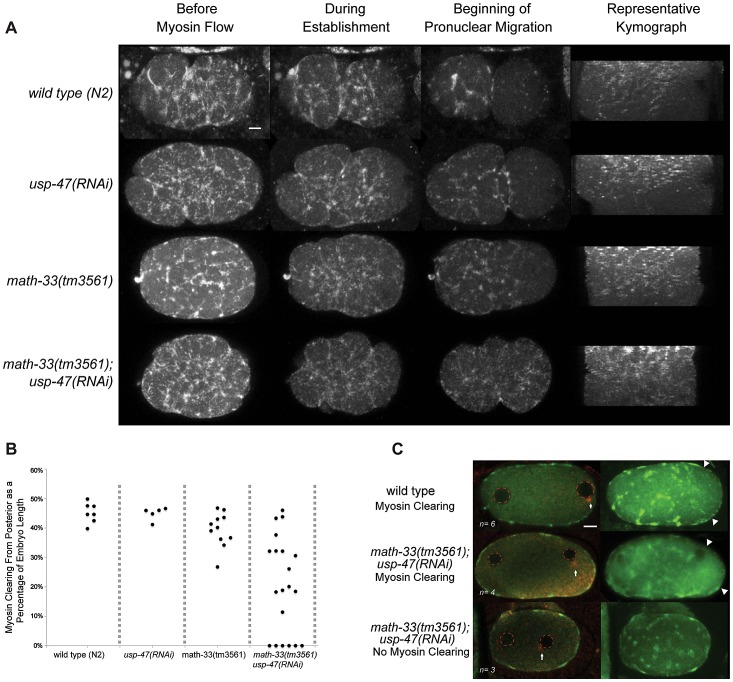
The posterior to anterior myosin clearing is defective in math-33(tm3561); usp-47(RNAi).(A) Time-lapse confocal images of embryos expressing NMY-2::GFP. The maximum projections of sections through the cortex of the embryo show the localization of NMY-2::GFP foci at three stages. Kymographs illustrate the pattern of myosin clearing and flow over time. About halfway through the kymographs (from top to bottom), large myosin foci transition into smaller myosin puncta. (B) The extent of myosin absence from the posterior (clearing) was measured as a proportion of the embryo length and the maximum level of clearing was recorded; each data point represents one embryo. (C) Confocal stacks of embryos immunostained for NMY-2 (green) and tubulin (red). Arrows indicate the location of the centrosome, red dotted circles mark the position of pronuclei, and the extent of myosin clearing is indicated by arrowheads. Scale bars represent 5 µm.